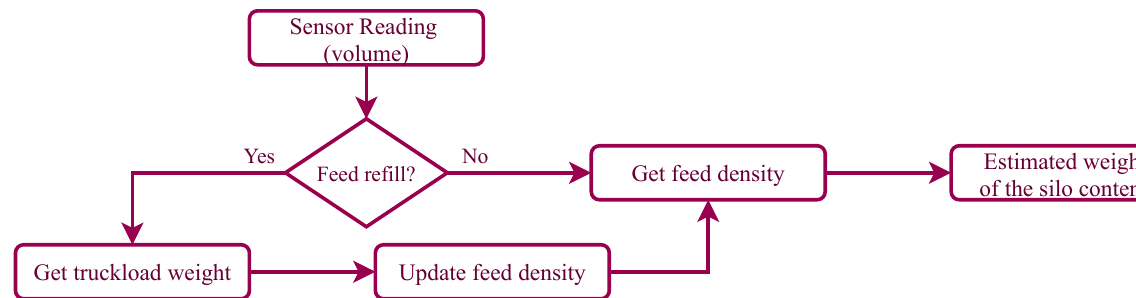
Figure 6. Estimation of the weight of the feed from the readings of the